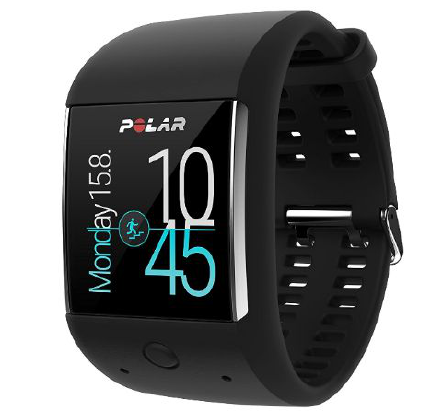
Figure 13. Polar M600 wearable